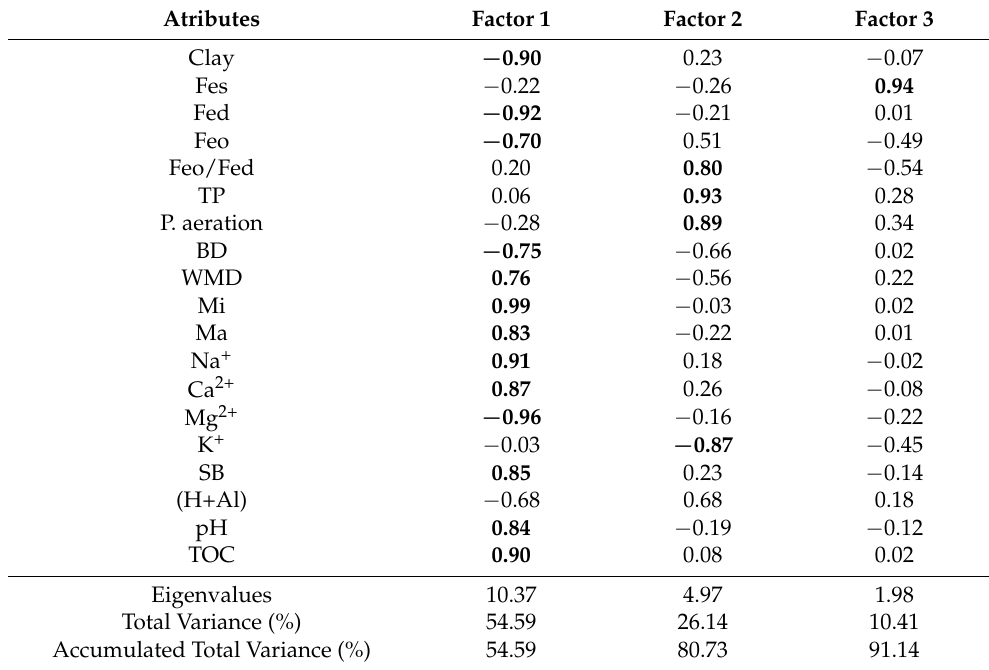
Table 7. Factorial axes extracted for soil attributes and their factor loadings, eigenvalues, total and cumulative